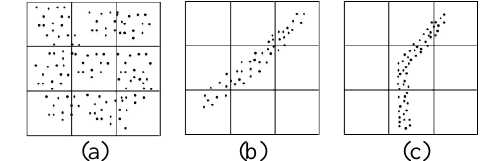
Figure 8. Sketch of surface and linear projection. (a) Planar; (b) Linear; (c) Polygonal.